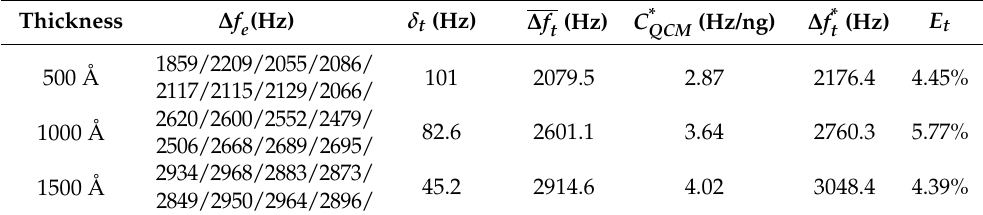
Table 2. Experimental results on the effect of different electrode thickness on the mass sensitivity of QCM